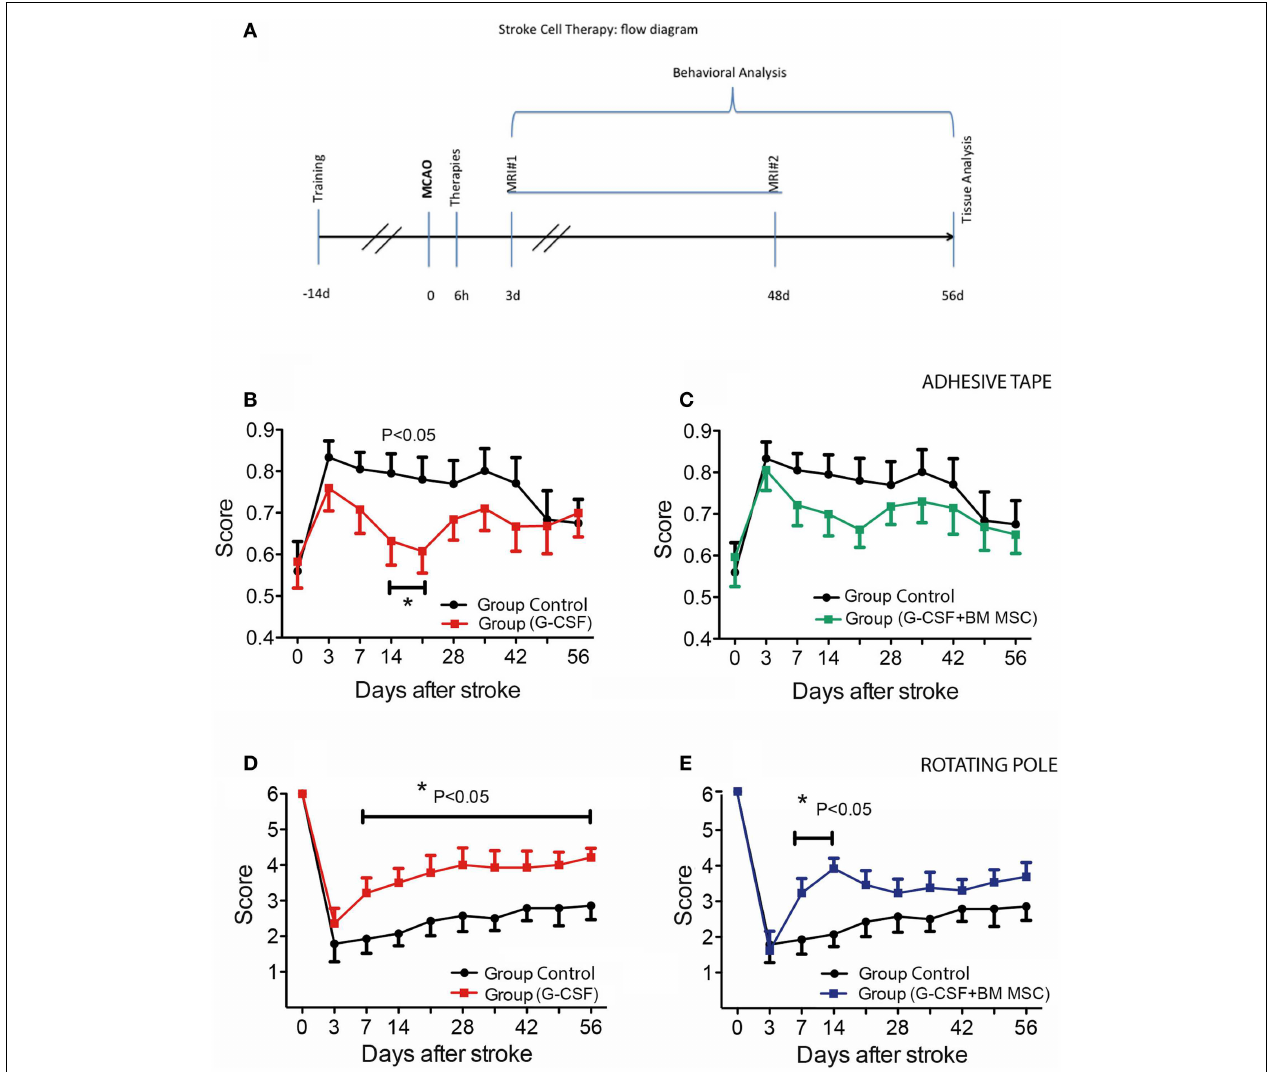
significant improvement of recuperation of sensorimotor function [ (C) , filled green squares] vs controls [ (C) , filled black circles]. (D,E) Functional recovery on the rotating beam. Control rats began improvement and recovered to 47% by day 56 [ (D) , (E) filled black circles]. Of the treated groups, best recovery of the bilateral sensorimotor coordination was shown in G-CSF alone that reached 72% of the pre-surgery value [ (D) , red squares] followed by G-CSF + BM MSC [58%; (E) , blue squares]. Data are given as mean ±